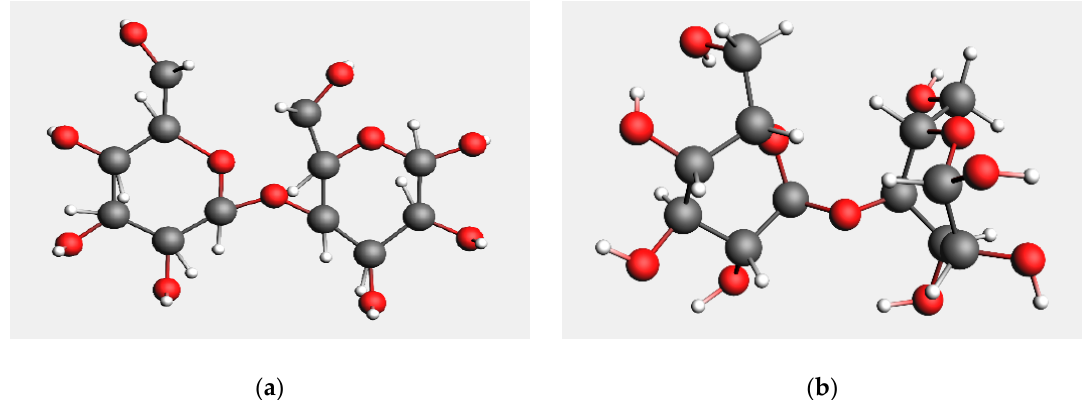
Figure 2. ( a ) The initial cellobiose; ( b ) the optimized cellobiose.